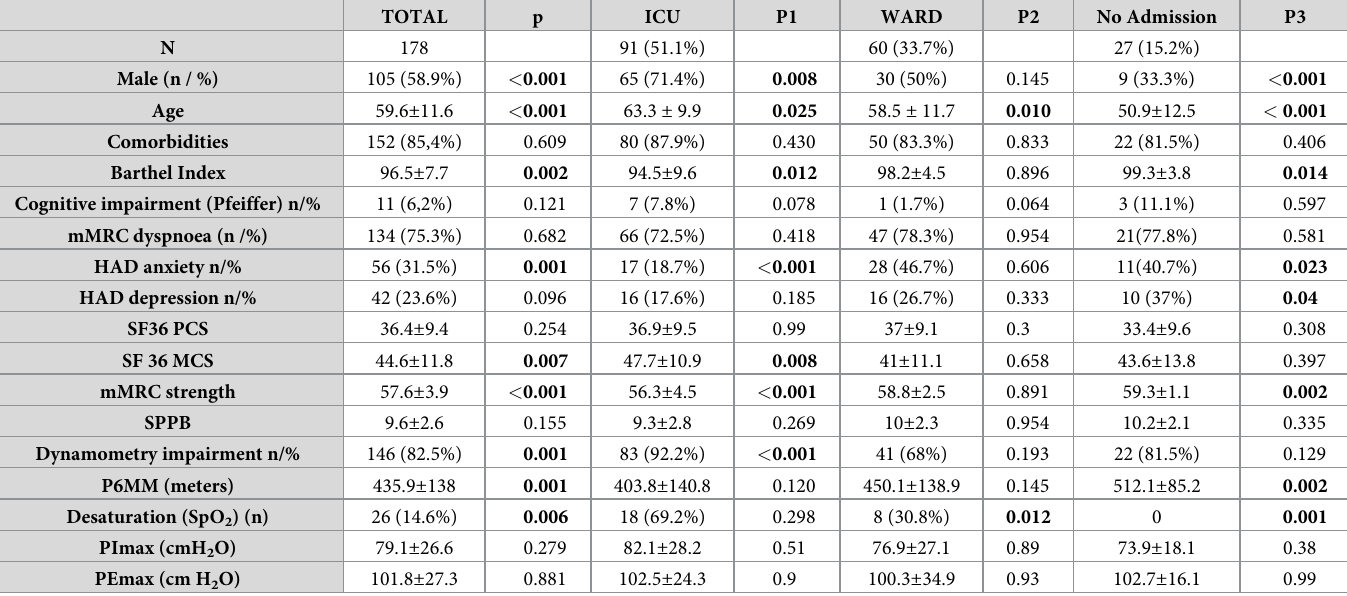
Table 2. Characteristics of the patients and results of the evaluation measures according to the severity